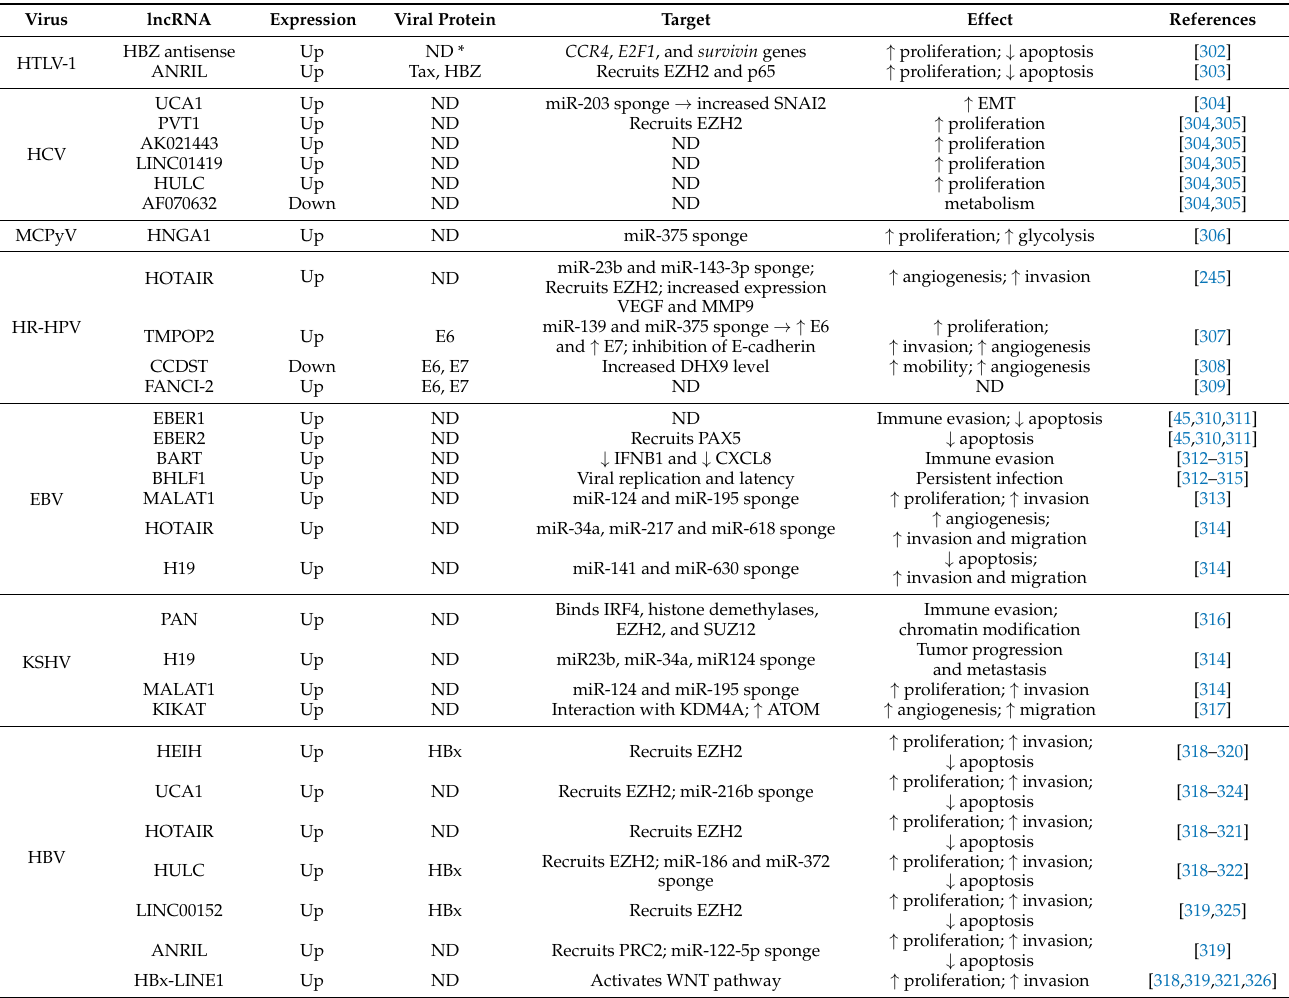
Table 4. Human tumor virus and lncRNAs with their targets and known functions in virus-induced cancer. See text for